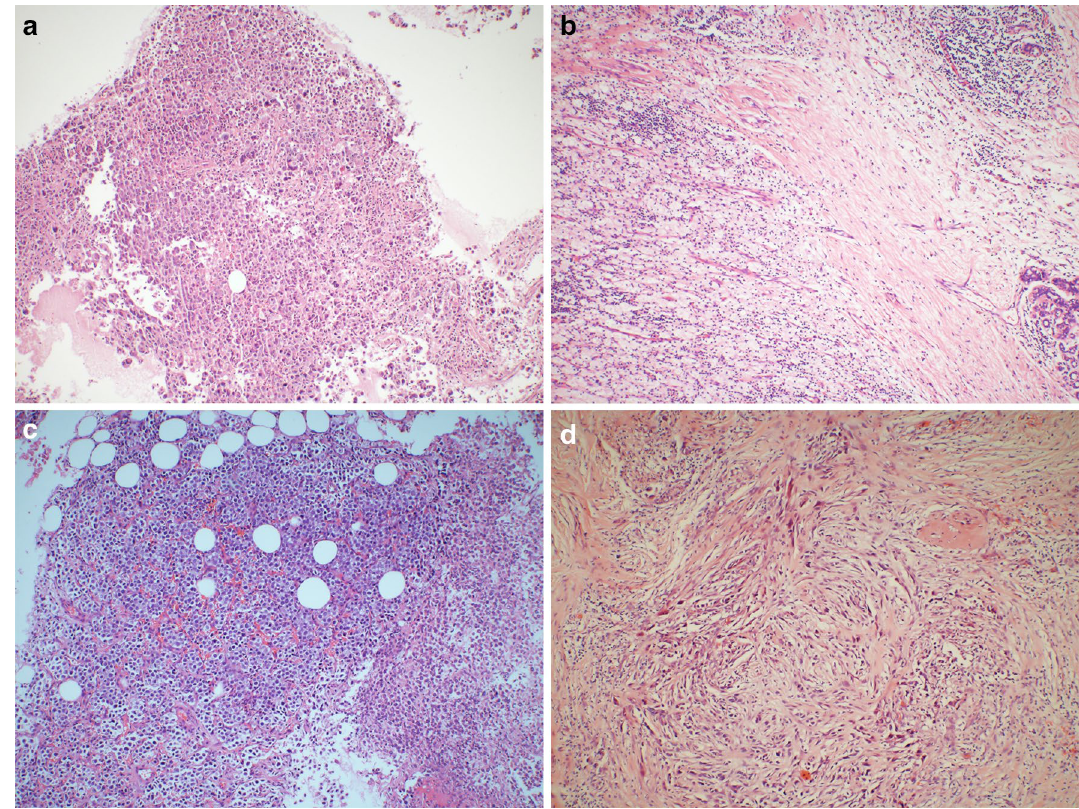
Figure 1. Pathological pictures (hematoxylin–eosin stain, original magnification × 100). ( a ) The preoperative puncture pathology of a patient in the observation group, showing a large number of tumor cells, ( b ) postoperative pathology, showing a large number of inflammatory cells, without tumor cells; ( c ) the corresponding preoperative puncture pathology picture of a patient in the control group, showing a large number of tumor cells, ( d ) the postoperative pathology, showing the residual tumor cells.